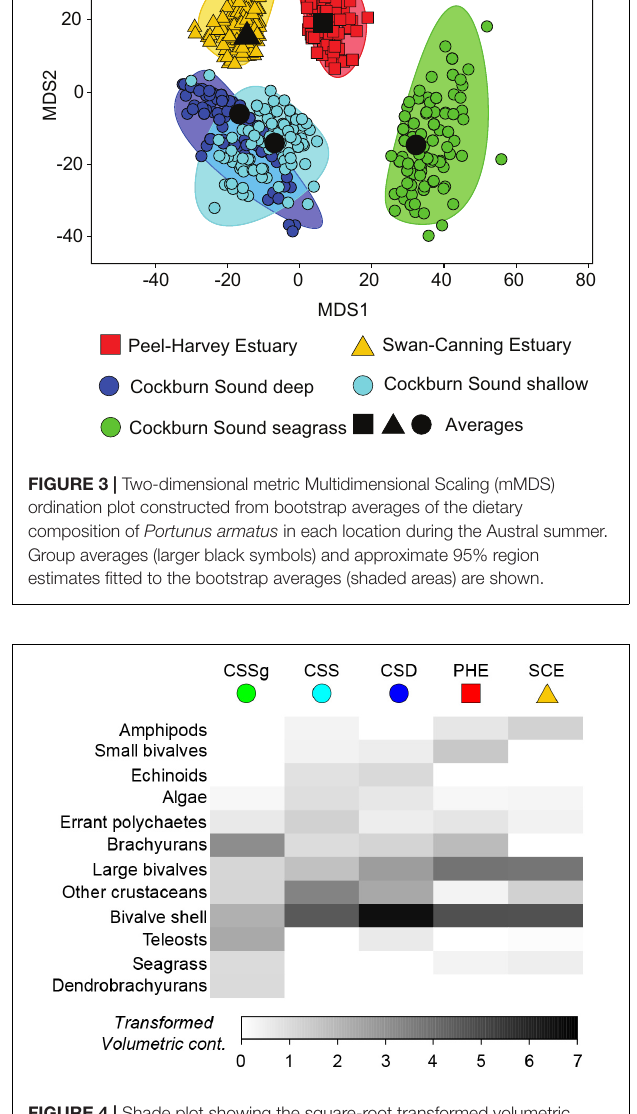
FIGURE 4 | Shade plot showing the square-root transformed volumetric contribution of the 12 most important dietary categories to the dietary composition of Portunus armatus each location in the Austral summer. PHE = Peel-Harvey Estuary, SCE = Swan-Canning Estuary, CSD = Cockburn Sound Deep sand, CSS = Cockburn Sound Shallow sand and CSSg = Cockburn Sound Seagrass.